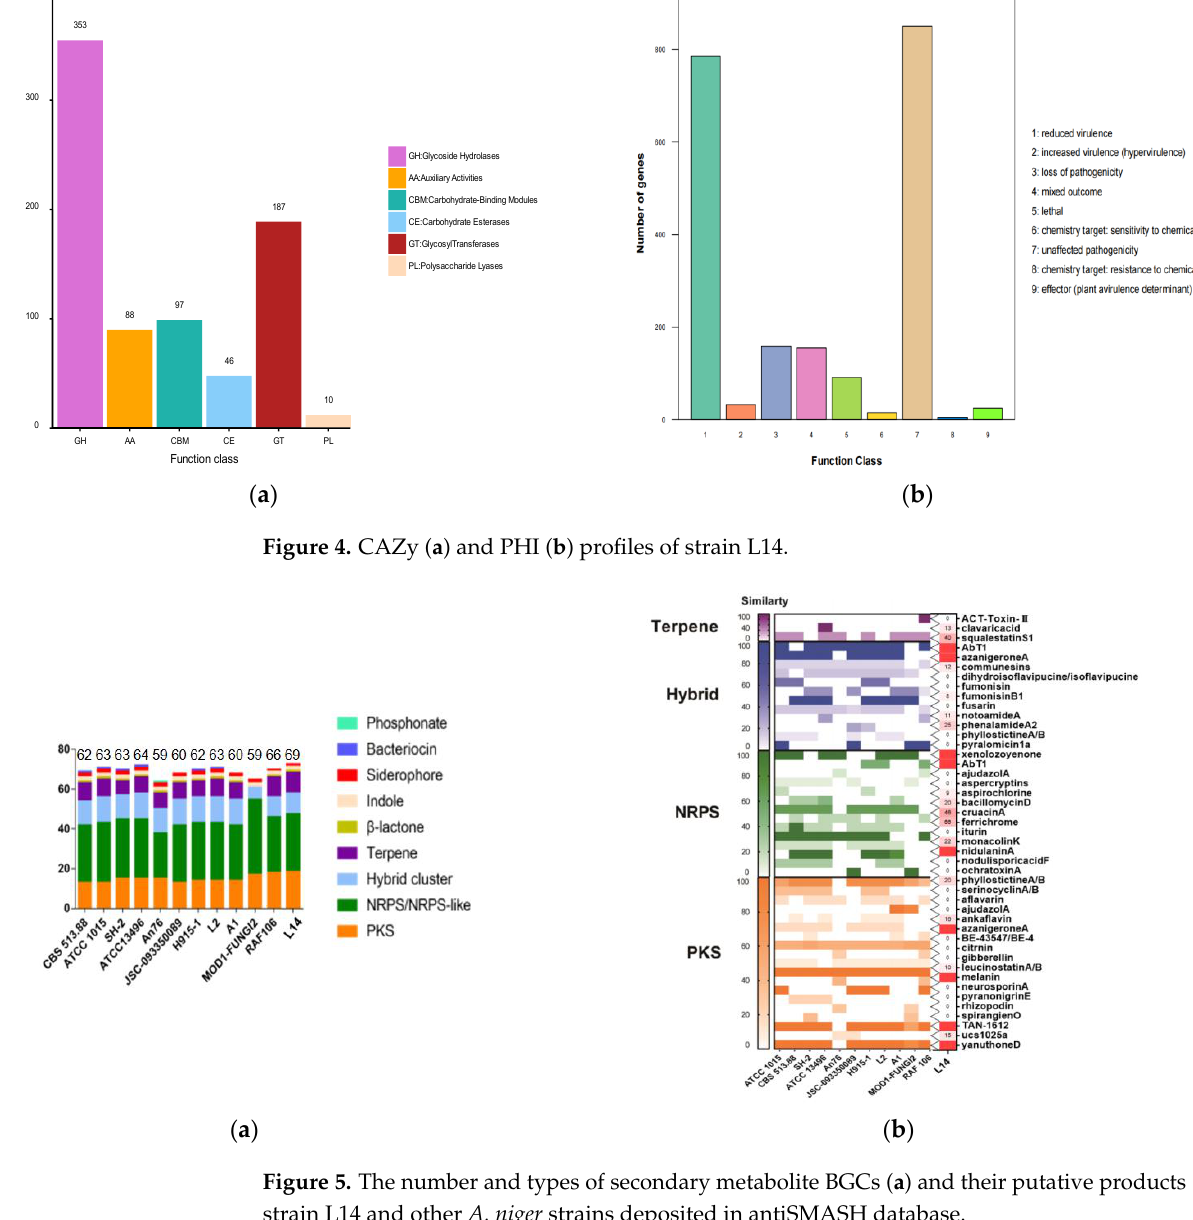
Figure 4. CAZy ( a ) and PHI ( b ) profiles of strain L14.